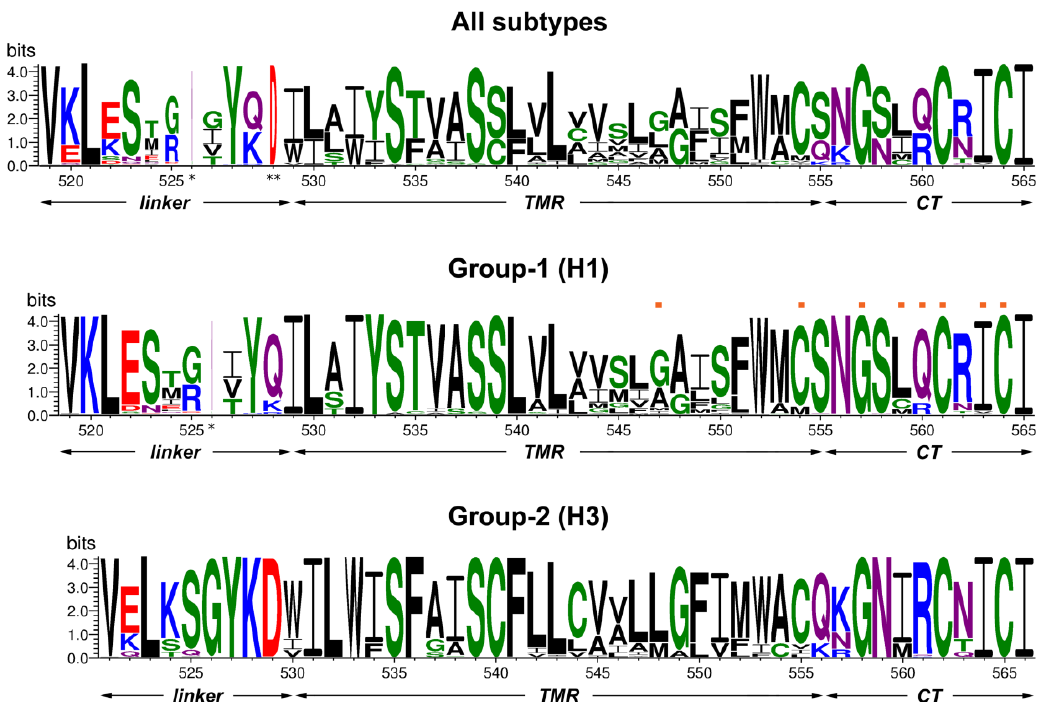
Figure 1. Conservation analysis of the C-terminal region of HA. Every unique HA sequence present in the database was used for the alignment represented by the WebLogo 3.3 server, either all subtypes together (upper panel) or group-1 (middle panel) and group-2 (lower panel) sequences separately. The overall height of the stack indicates the sequence conservation at that position, while the height of symbols within the stack indicates the relative frequency of each amino acid at that position. Gaps found in all HA subtypes (except small samplings of H11, H13, H16 sequences) and in all group-1 subtypes (compared to the group-2 ones) are marked with one or two asterisks, respectively. Amino acid numeration correspond to the HA from A/WSN/33 (H1N1) (UniProt Acc. B4URE7) in the upper and middle panel and to the HA from A/Udorn/72 (H3N2) (UniProt Acc. Q20MD6) in the lower panel. The relative borders of the linker region, transmembrane domain (TMD) and cytoplasmic tail (CT) are indicated. The residues mutated in HA from WSN are marked with orange rectangles above the group-1 logos.